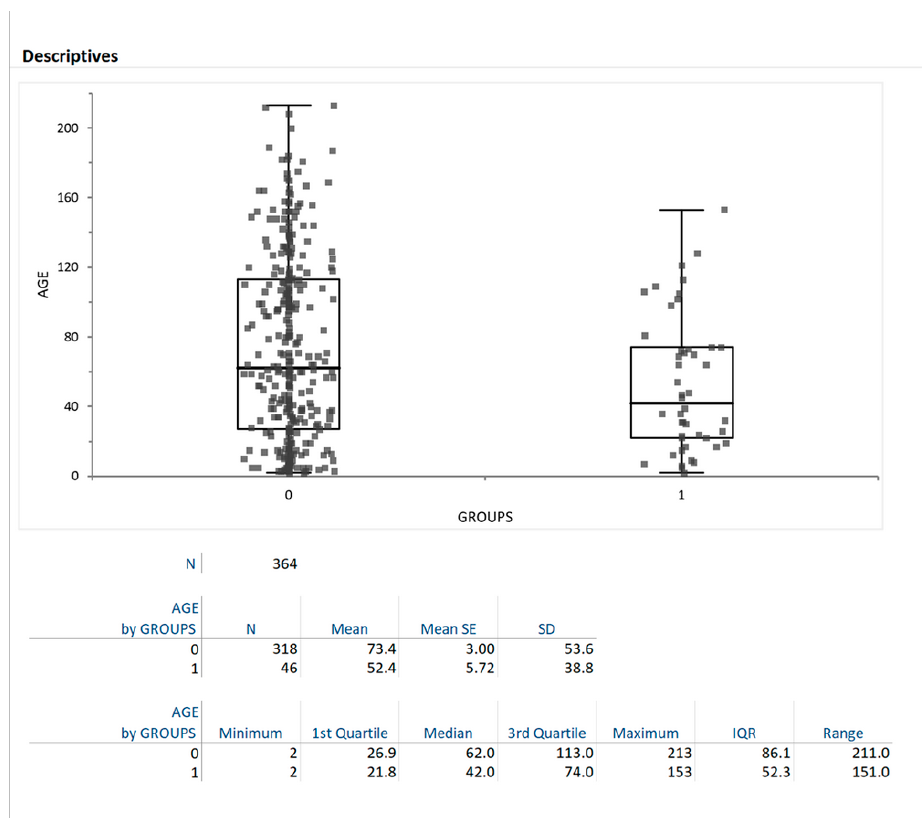
Figure 1. Box plot graph showing the body weight distribution in group 0 (control group) and affected group (group 1).